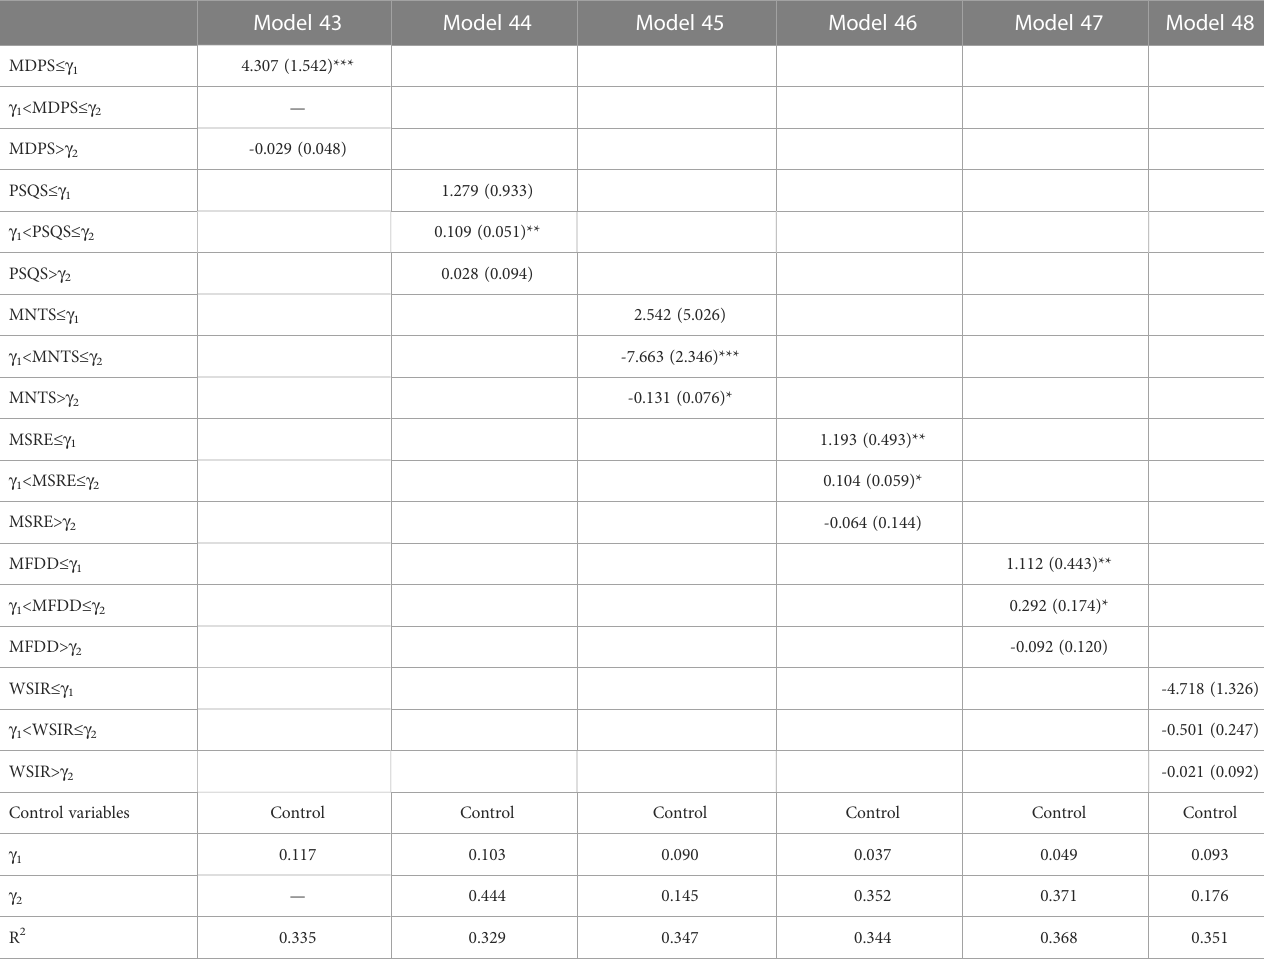
TABLE 8 The threshold model results of GTCG in the major grain producing